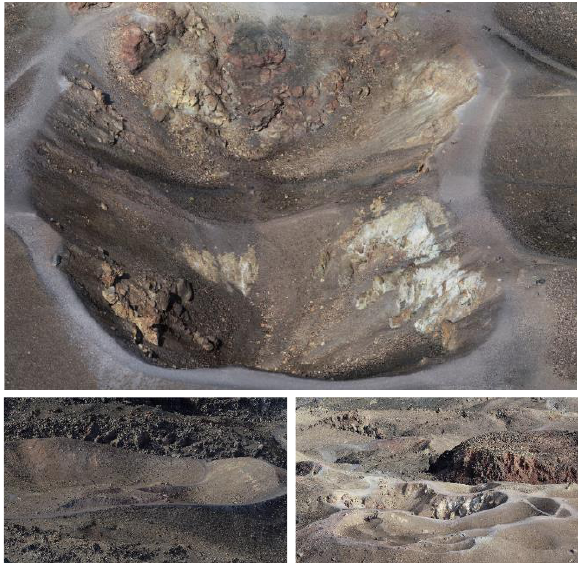
Figure 11. 3D Reconstruction results of Kameni island.